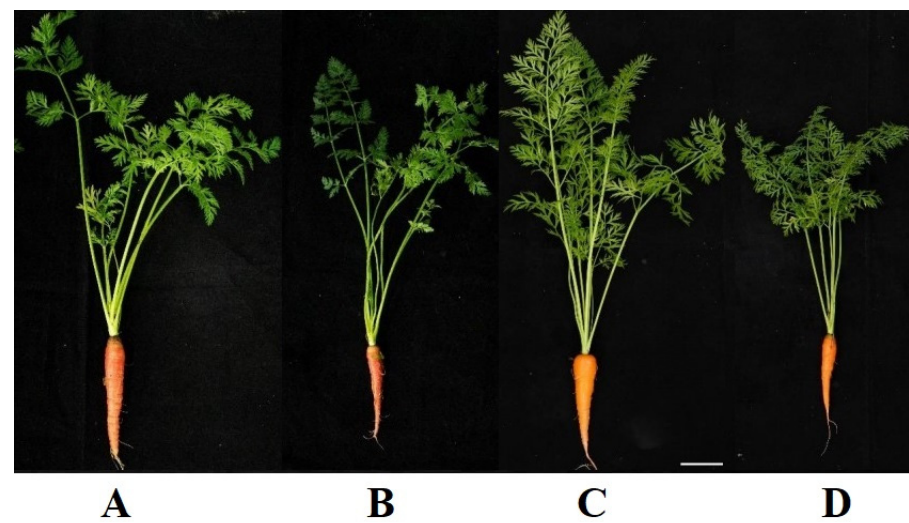
Figure 1. Phenotype of carrot under salt stress. ( A ) ‘BHJS’ CK; ( B ) ‘BHJS’ under salt stress; ( C ) ‘KRD’ CK; ( D ) ‘KRD’ under salt stress. Bar = 5 cm. Salt Stress: NaCl solution (300 mmol·L − 1). CK: Distilled water.